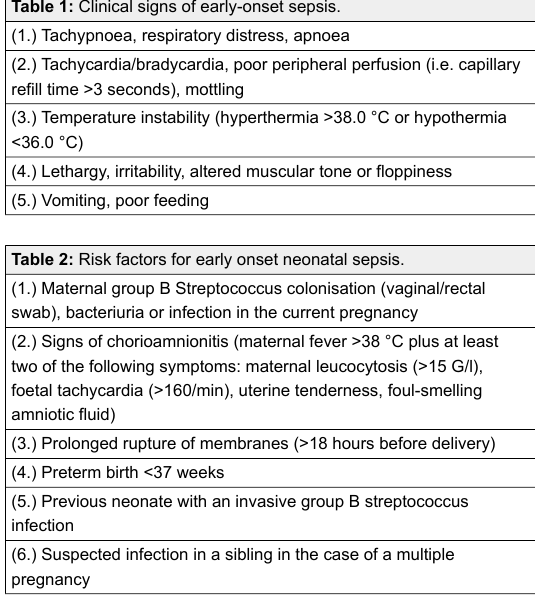
Table 1: Clinical signs of early-onset sepsis.